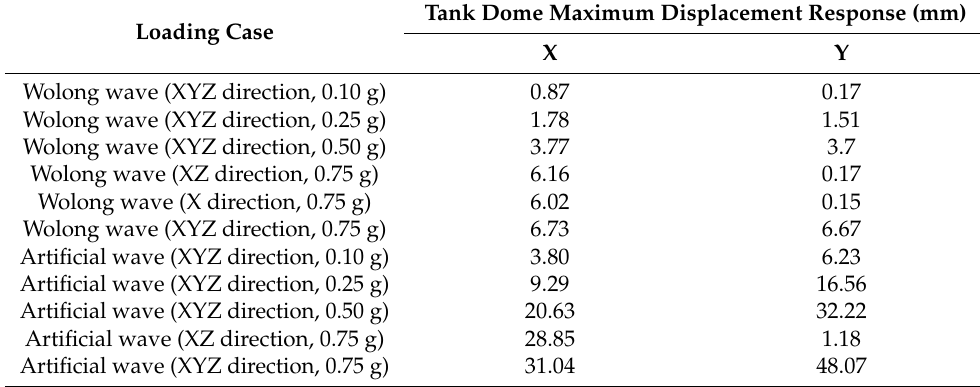
Table 3. Maximum displacement of tank dome under different loading